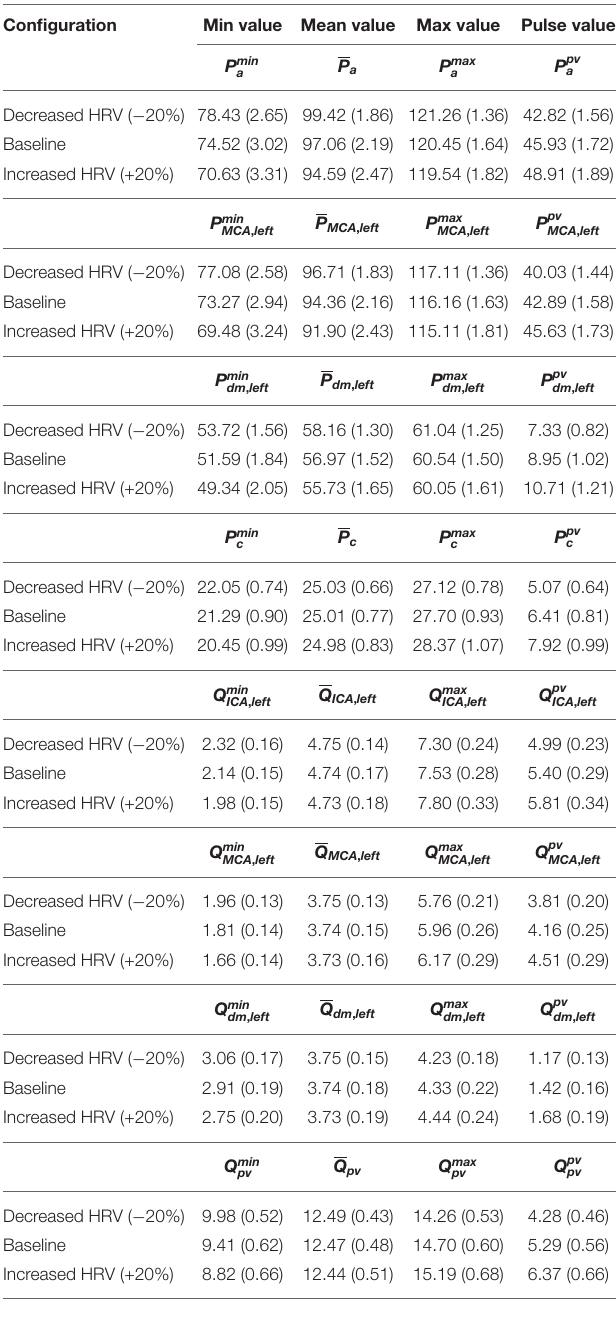
TABLE 2 | Mean and standard deviation (in brackets) values for the minimum ( P min and Q min ), average ( P and Q ), maximum ( P max and Q max ), and pulse ( P pv and Q pv ) values per beat of P and Q along the ICA-MCA pathway: P a , Q ICA , left , P MCA , left , Q MCA , left , P dm , left , Q dm , left , P c , and Q pv